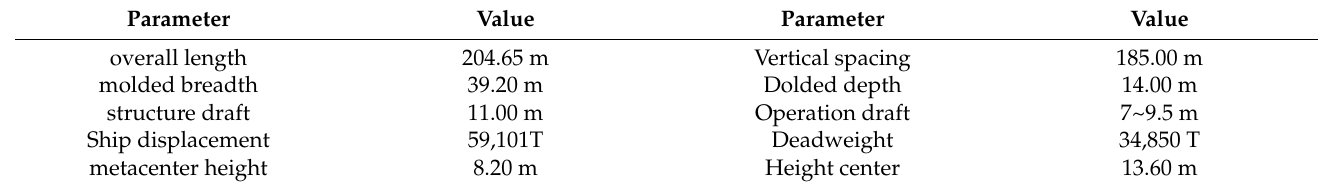
Table 3. Vessel parameters.